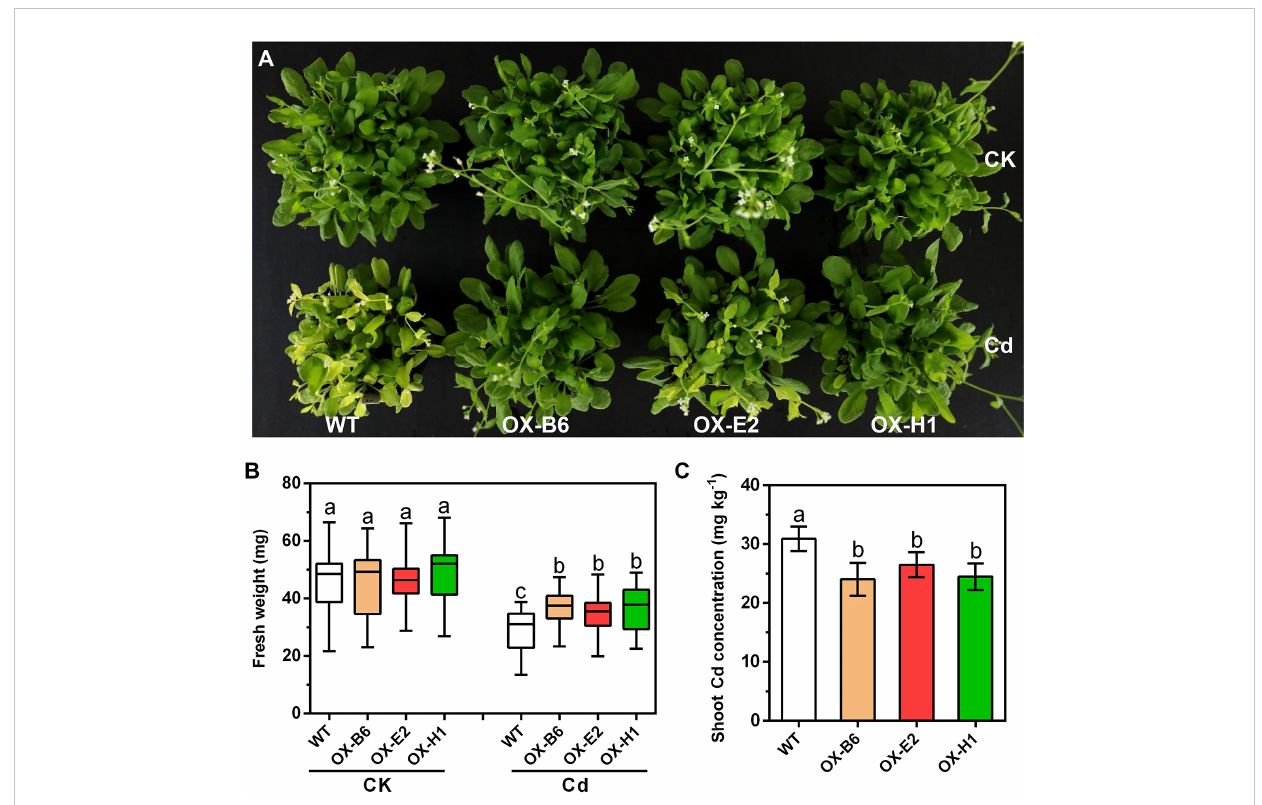
FIGURE 2 Overexpression of GmWRKY172 conferred Cd tolerance in Arabidopsis thaliana . (A) Phenotypes of Arabidopsis thaliana transgenic lines (OX-B6, OX- E2, and OX-H1) and WT under normal or Cd-treated conditions. OX refers to GmWRKY172 overexpression. (B) Boxplots for the shoot fresh weight of each plant in different treatment conditions ( n = 30). (C) Shoot Cd concentrations of WT and transgenic lines, data are expressed as mean ± SD ( n = 5). Different letters indicate statistical signi fi cance determined by one-way analysis of variance and Duncan ’ s test ( P ≤